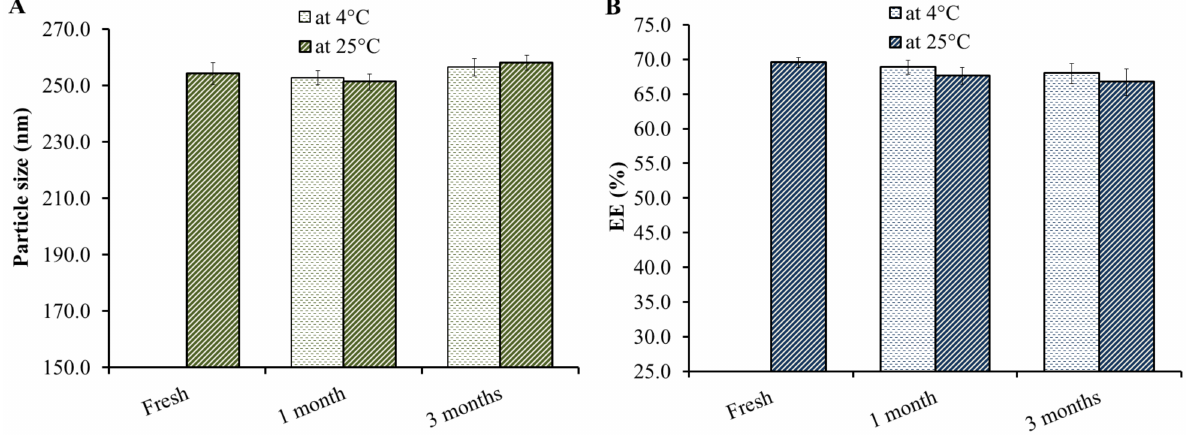
Figure 9. Stability study of ATO-NLC formulation after 25 ± 2 ◦ C and 5 ± 2 ◦ C for 1 and 3 months in terms of ( A ) particle size and ( B )